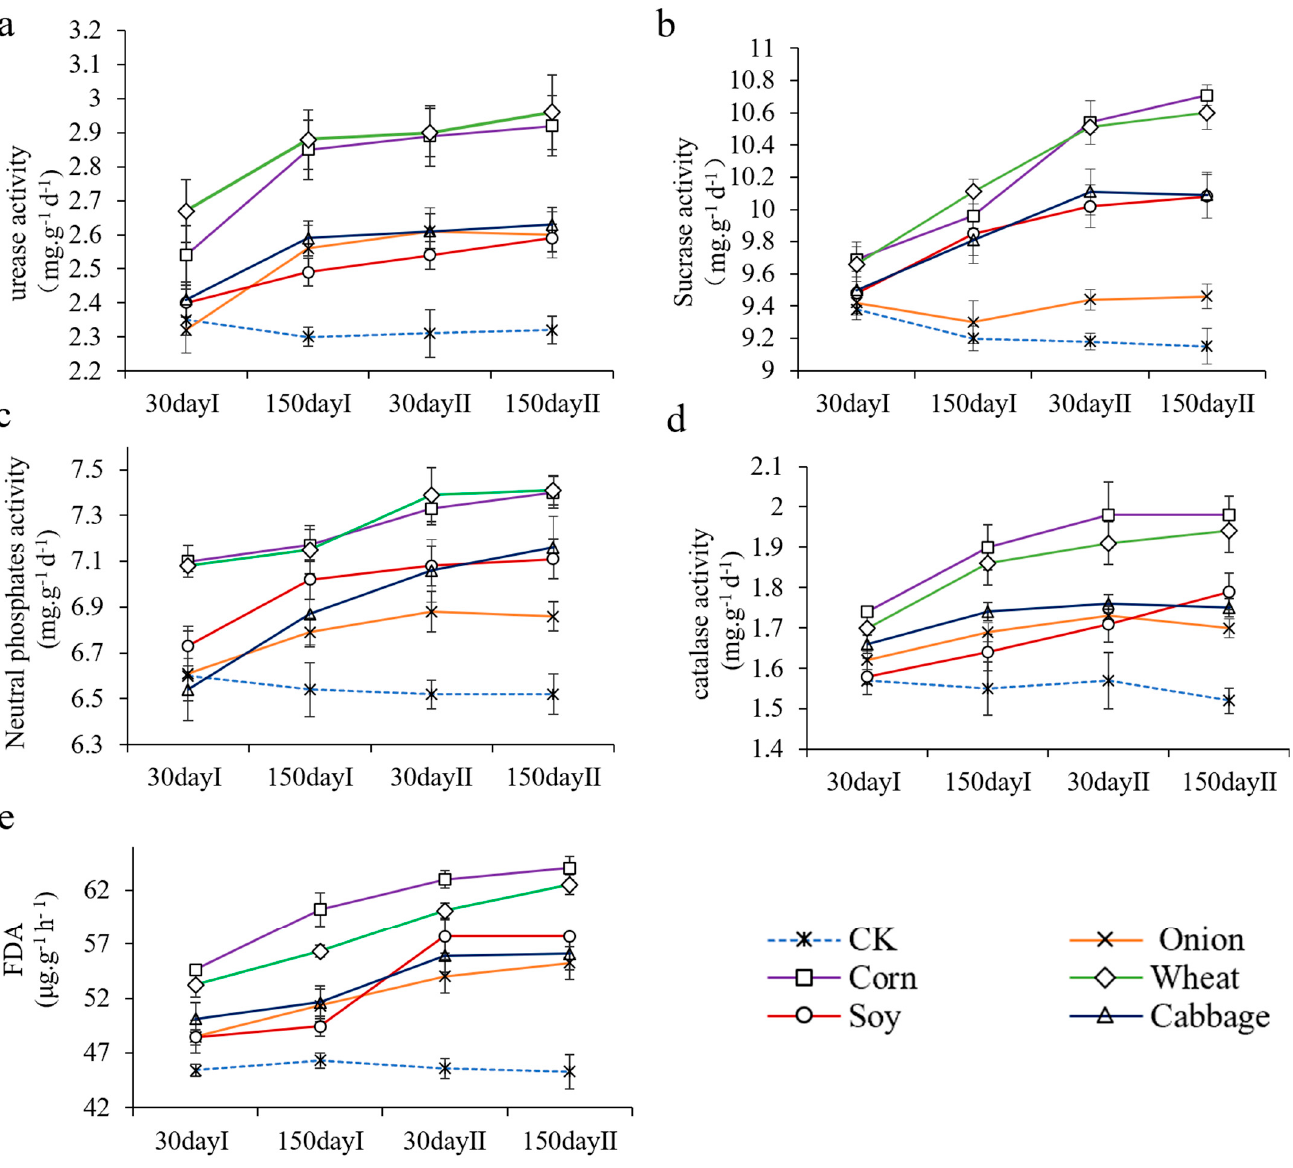
Figure 2. Effects of different catch crops on soil-enzyme activities. Urease activity ( a ), Sucrase activity ( b ), Neutral phosphates activity ( c ), Catalase activity ( d ), Organic matter ( e ). FDA–fluorescein diacetate, expressed as μ g fluorescein g − 1 soil h − 1 .